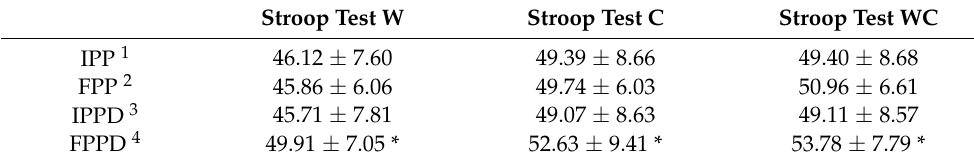
Table 2. Evolution of results obtained over time in Stroop test with product and